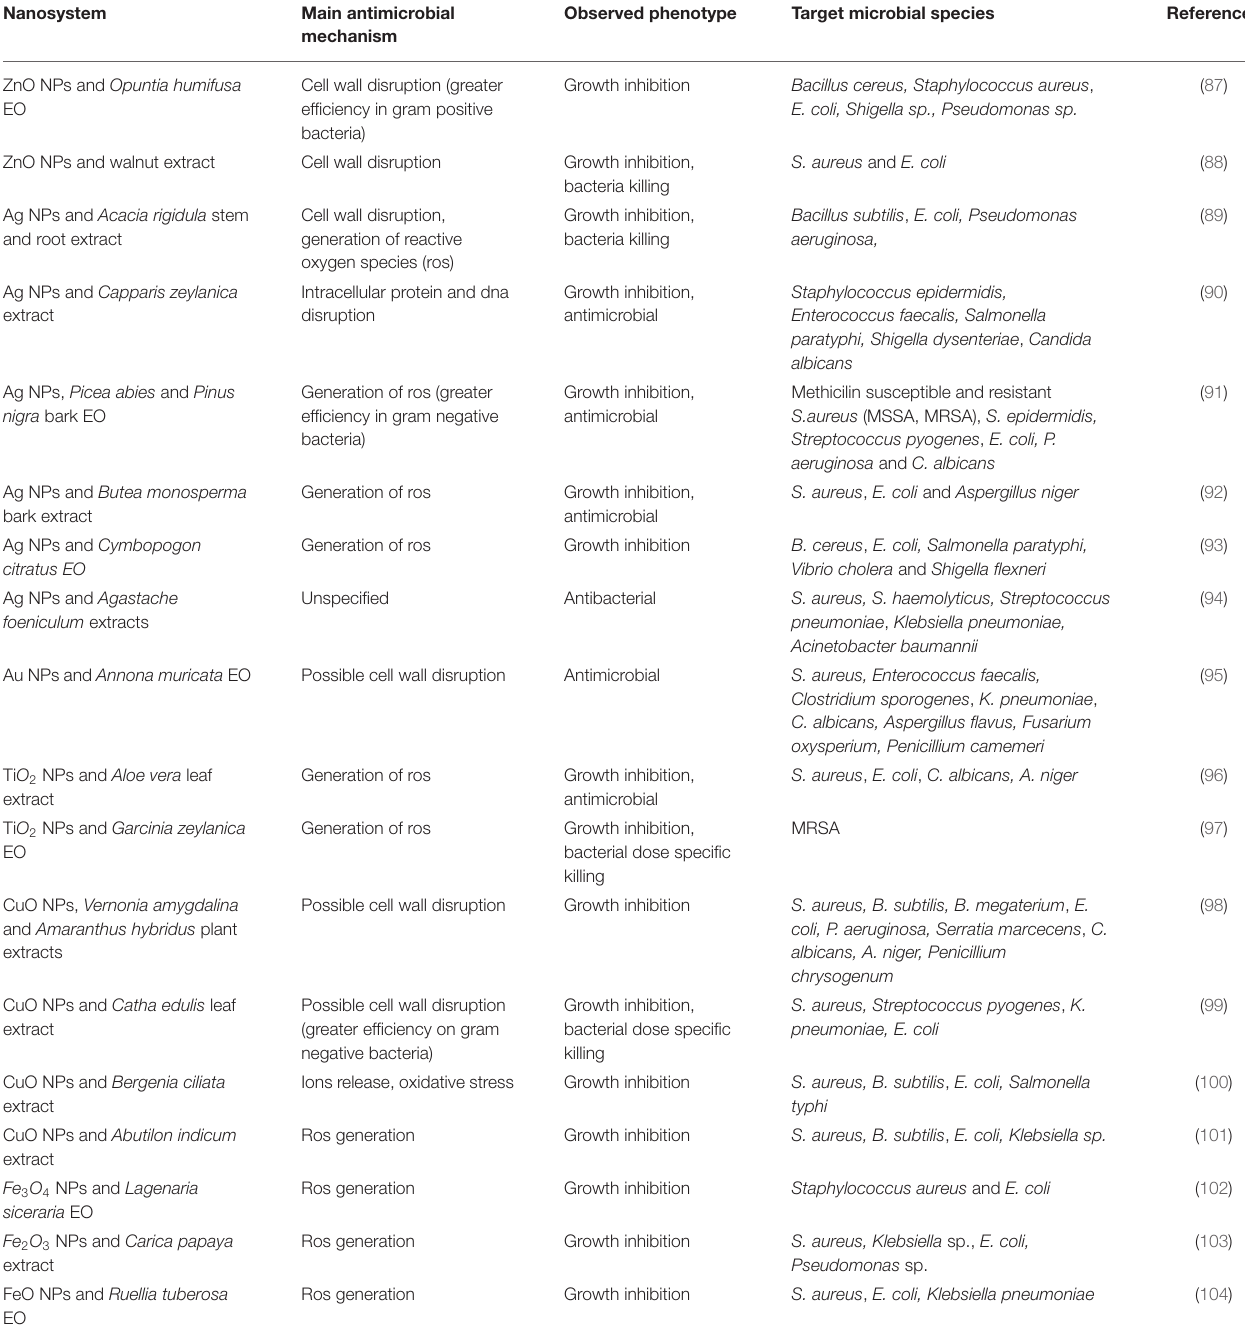
TABLE 2 | Antimicrobial activity of NPs-EOs combinations in gut or food pathogens.